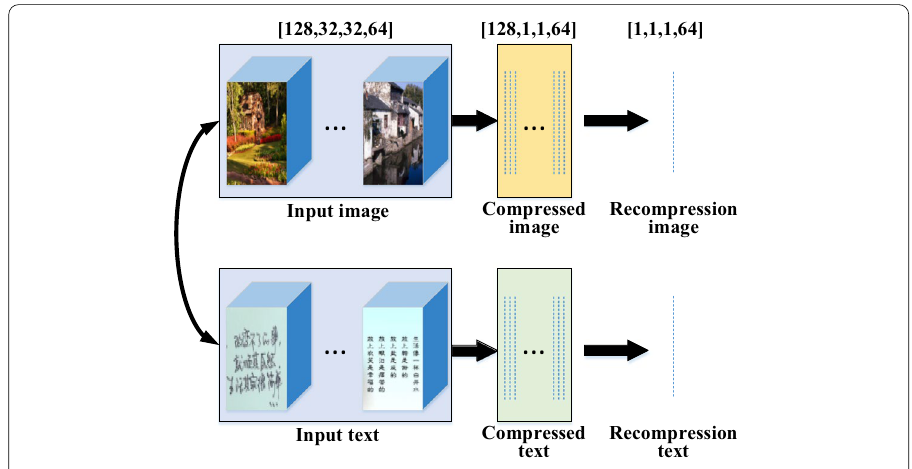
Fig. 2 Optimization principle of batch-normalization